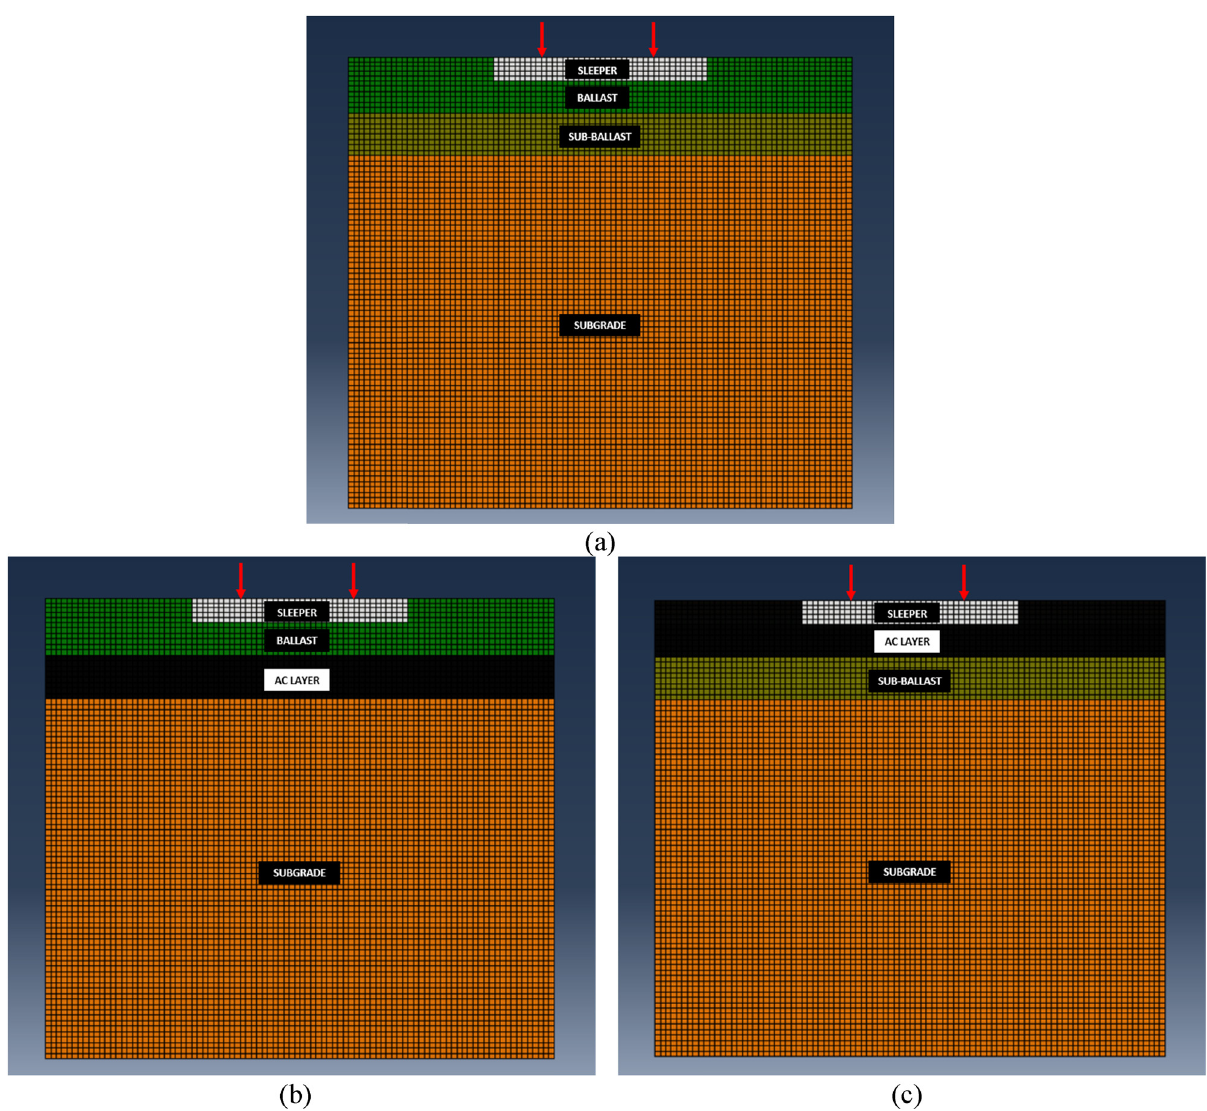
Figure 5: 2D mesh of simulation models: ( a ) Indonesia ’ s ballasted track, ( b ) asphaltic underlayment track, and ( c ) asphaltic overlayment